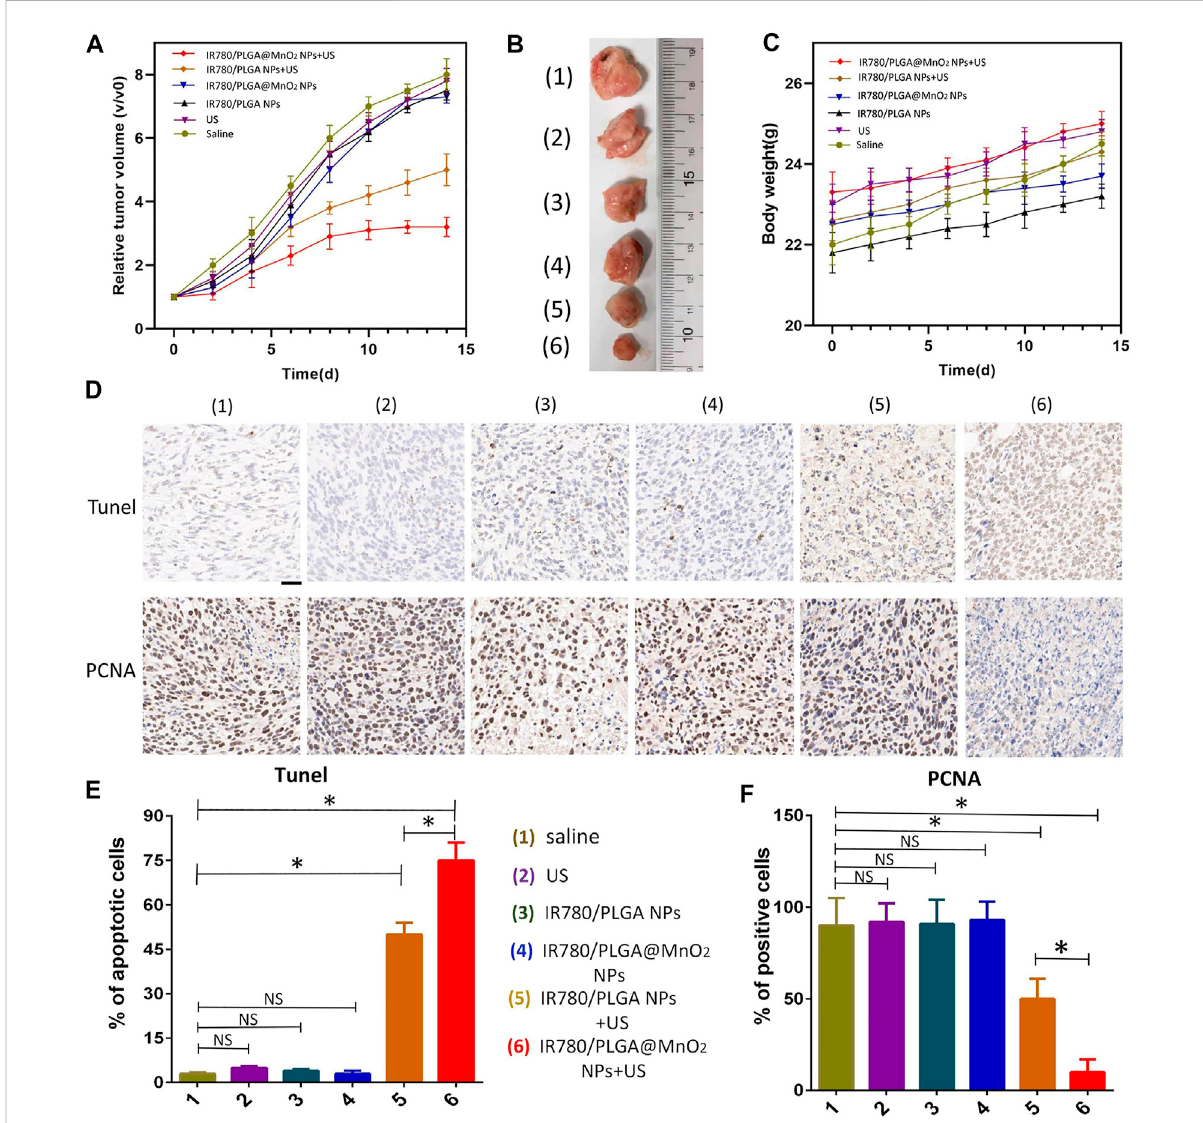
FIGURE 9 (A) The relative tumor growth curves and (B) photographs of tumors during the various treatments after 14 days. (C) The weight growth curves of different groups of mice after various treatments. (D) Microscopy images of TUNEL and PCNA assays of stained tumor tissues at different treatments: (Hussain and Nguyen, 2014) Saline, (Wells, 2006) US, (Wu et al., 2005) IR780/PLGA NPs, (Ahmadi et al., 2020) IR780/PLGA@MnO 2 NPs, (Qian et al., 2016) IR780/PLGA NPs + US, (Wood and Sehgal, 2015) IR780/PLGA@MnO 2 NPs + US (scale bar, 200 µm). (E) The relative quanti fi cation of TUNEL and (F) PCNA after different treatments. (* p <